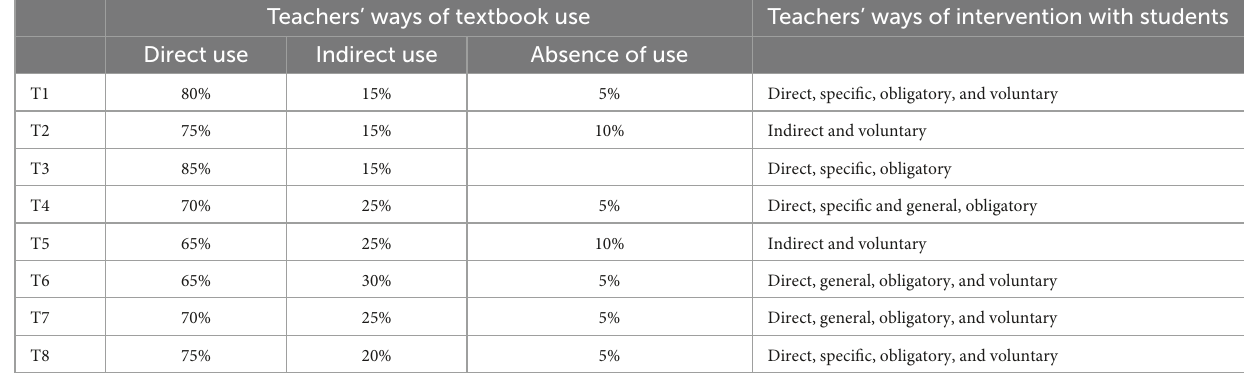
TABLE 7 Teachers’ ways of textbook use and ways of interventions with